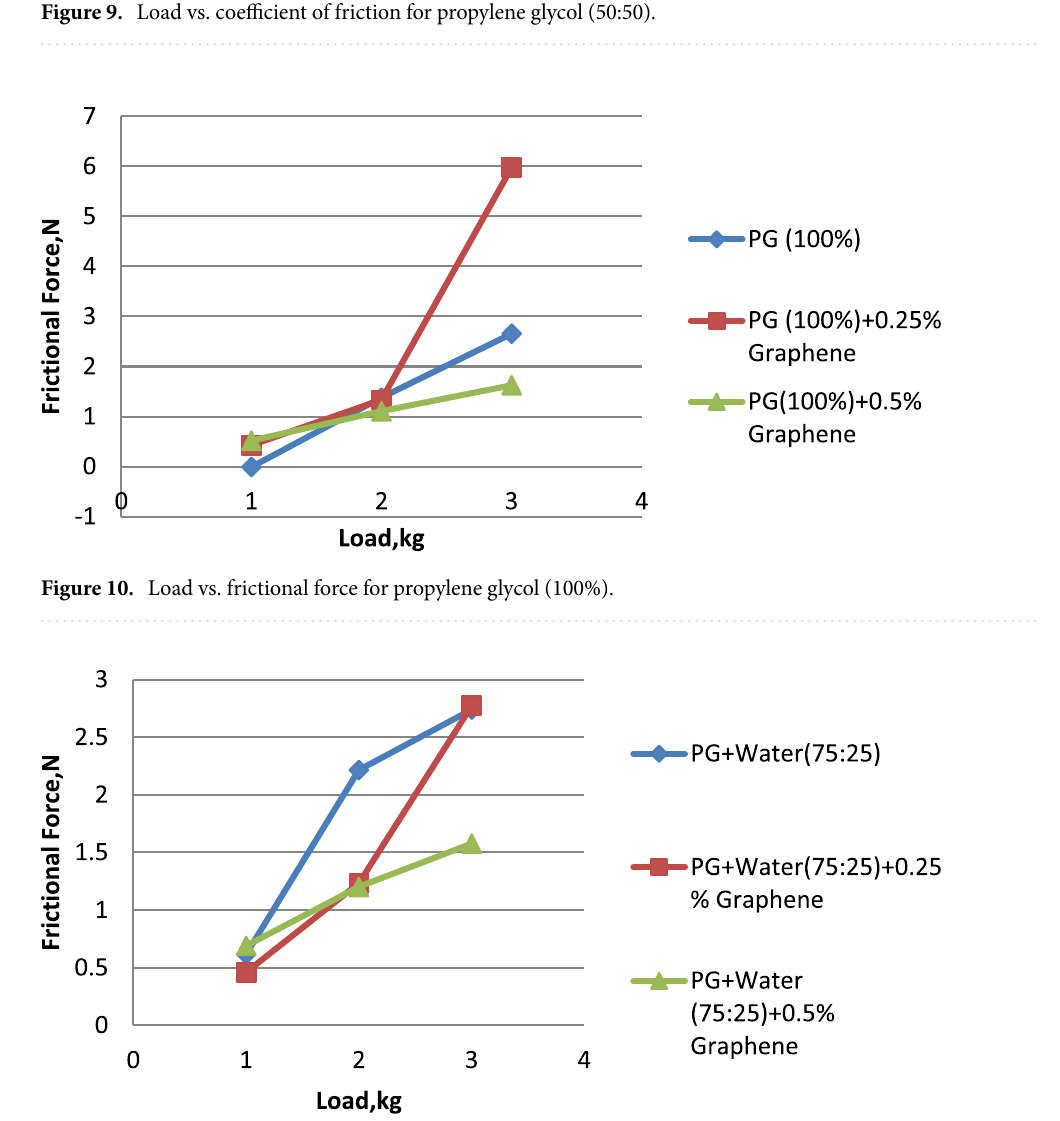
Figure 11. Load vs. frictional force for propylene glycol